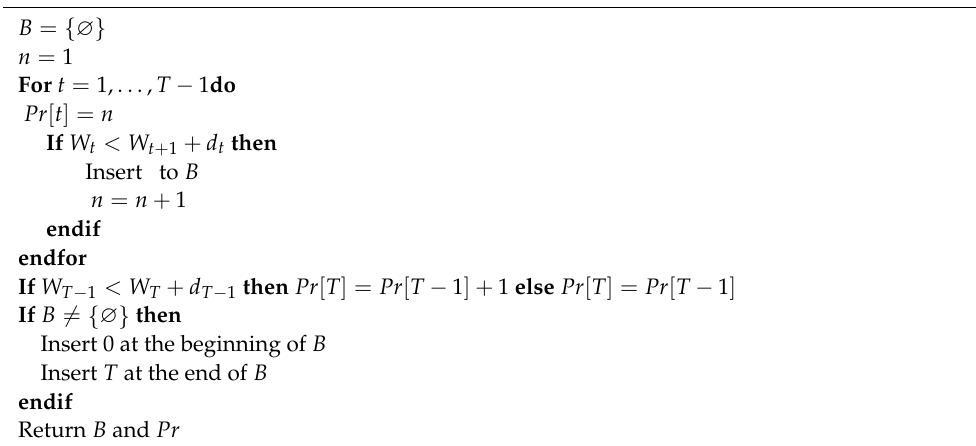
Procedure 1: Construct the sorted list B and the array Pr in O ( T